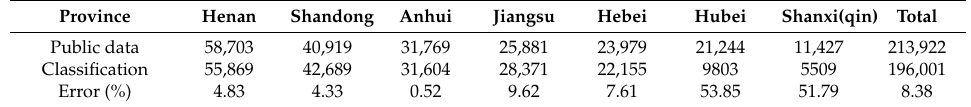
Table 3. Compared with public data at a provincial scale (km 2 ).